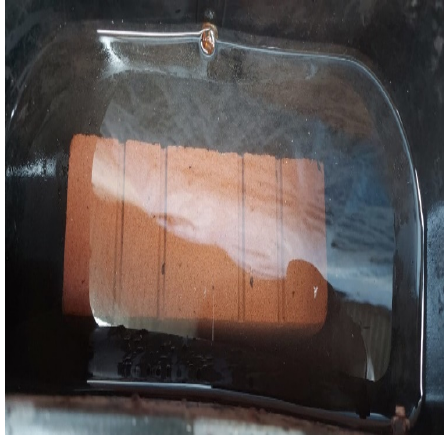
Figure 13. SRMB immersed in water.